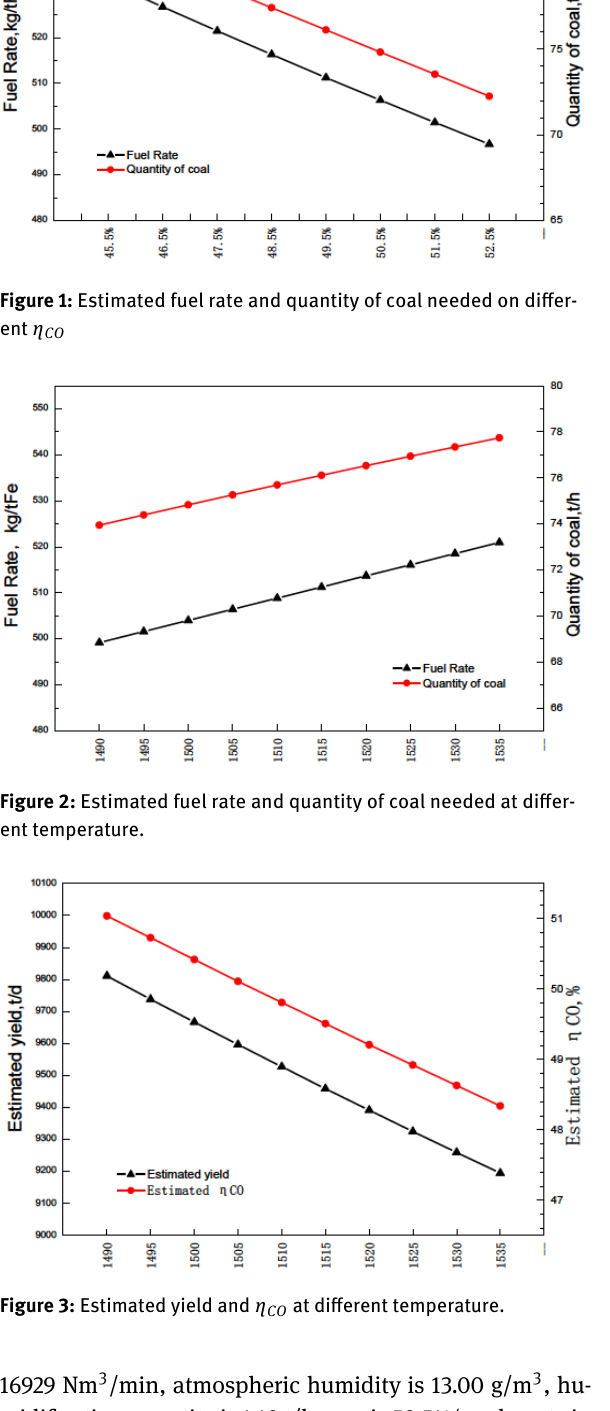
16929 Nm 3 /min, atmospheric humidity is 13.00 g/m 3 , hu- midification quantity is 1.10 t/h, η is 50.51%, coke rate is CO 336.56 kg/tFe, operation yield is 9558.72 t/d, and estimated molten iron temperature is 1507 ∘